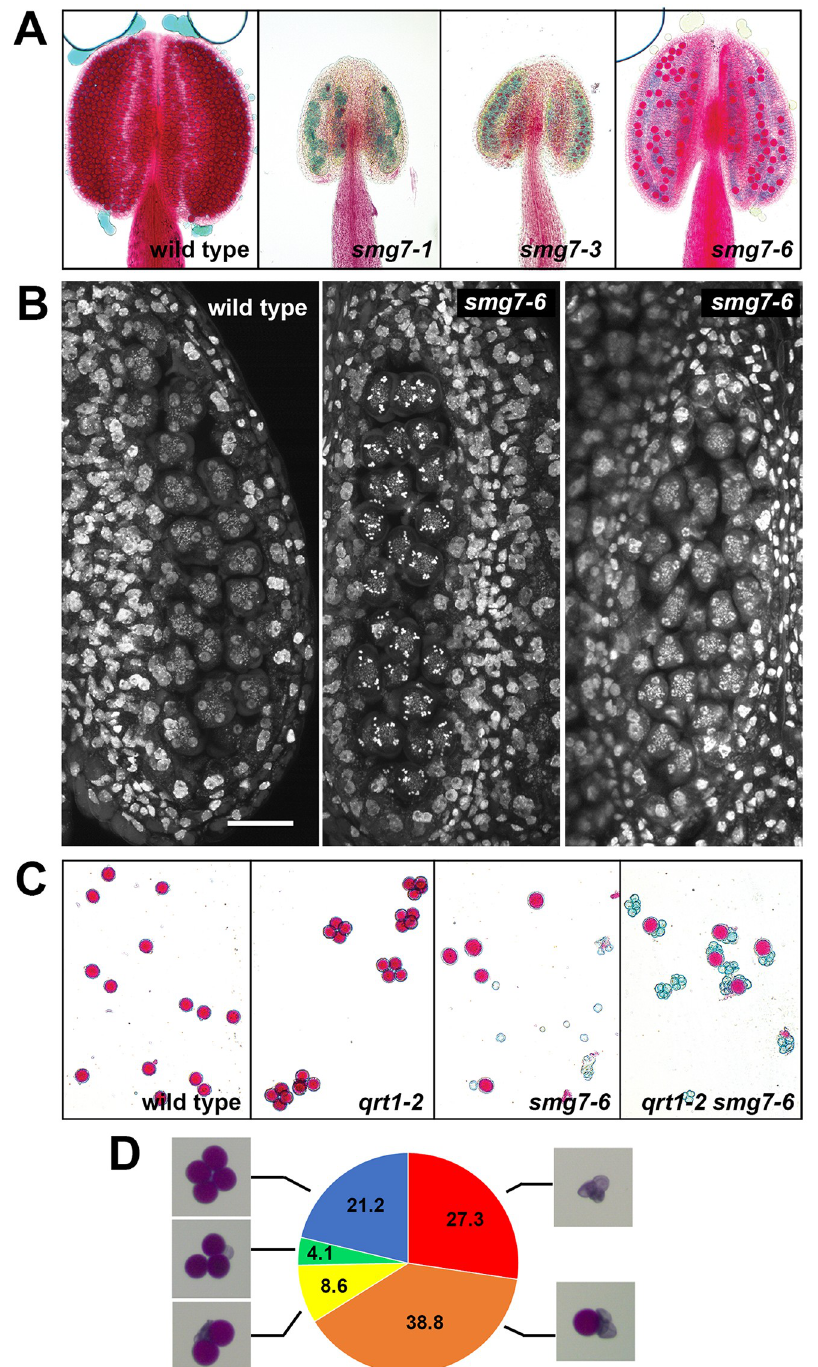
Fig 1. Aborted pollen development in smg7-6 mutants. (A) Anthers of indicated mutants after Alexander staining. Viable pollen stain red. (B) Anther loculi in telophase II (Col-0, smg7-6 left panel) and assumed aberrant anaphase II ( smg7-6 , middle panel) stained with DAPI. Scale bar corresponds to 20 μ m. (C) Alexander staining of pollen produced by the indicated mutants. The qrt1-2 mutation causes pollen from one tetrad to remain together. (D) Percentage of tetrads with one, two, three, four or no viable pollen. 245 tetrads from qrt1-2 smg7-6 plants were counted.